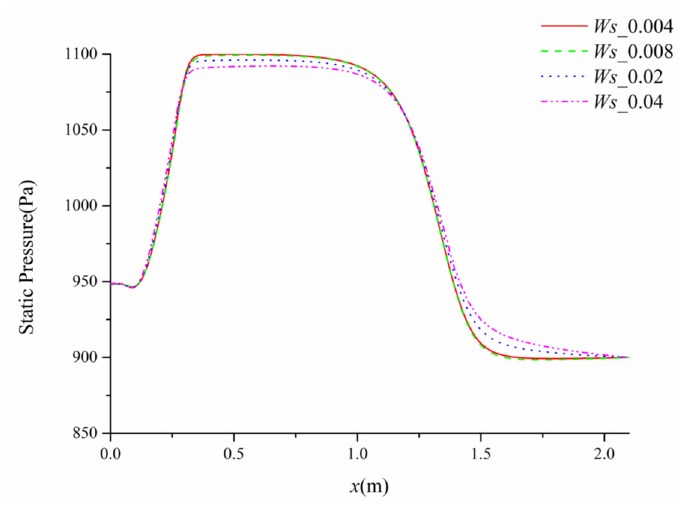
Figure 15. Axial static pressure under different inlet particle mass flow rates.